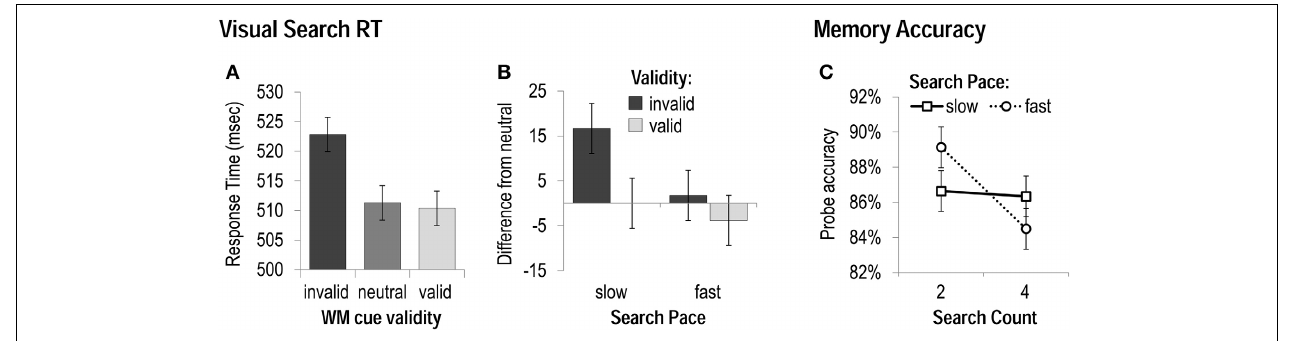
FIGURE 2 | Task performance in Experiment 1. (A) Response Times—collapsed across all mini-block conditions—when WM cues were matching visual search distracters (invalid), targets (valid), or did not reappear in the search display (neutral). (B) The magnitude